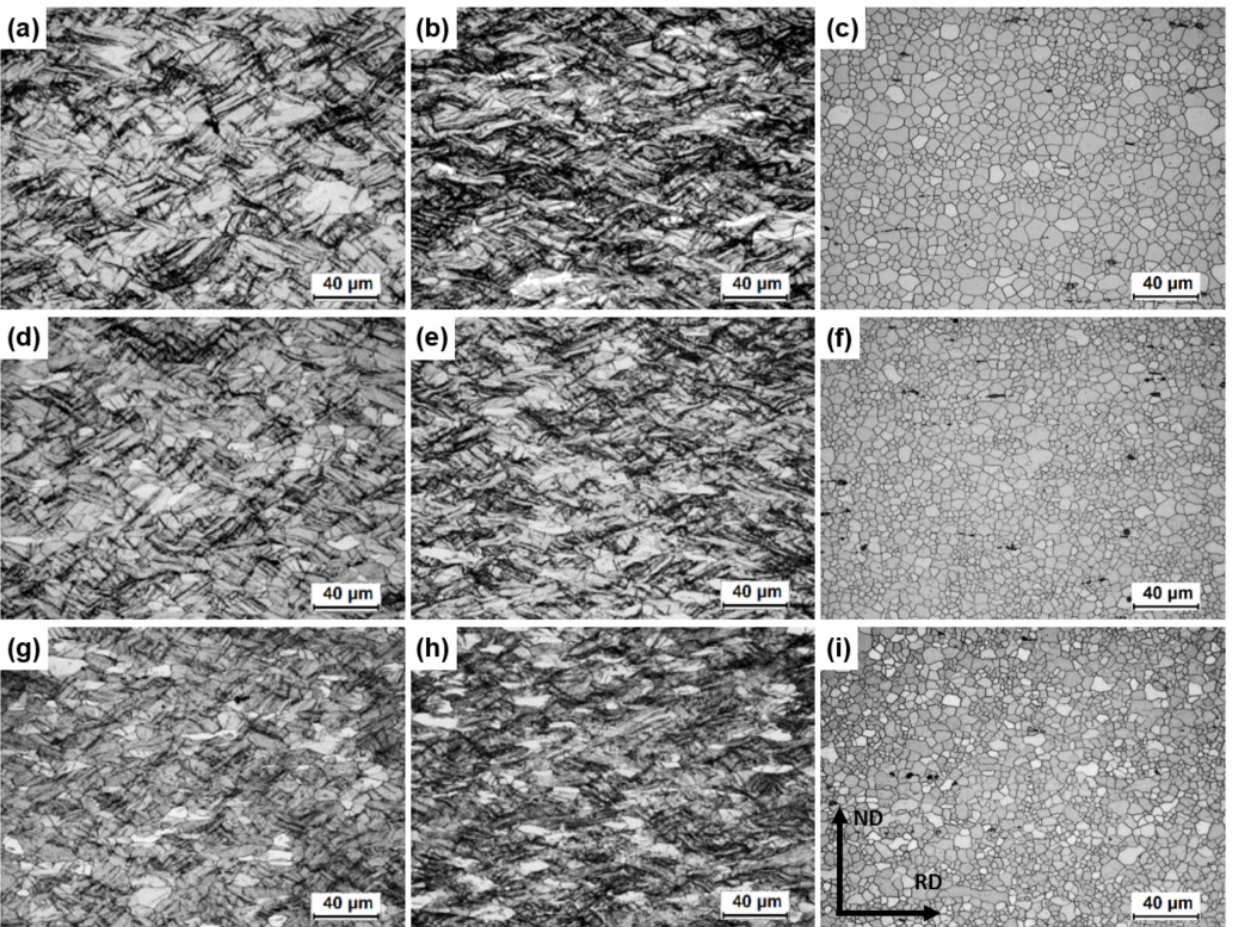
Figure 1. Optical micrographs of the hot-rolled ( a , d , g ), cold-rolled ( b , e , h ), and subsequently an- nealed ( c , f , i ) sheets: ( a – c ) AZXW3100, ( d – f ) AZXW2100, and ( g – i ) AZXW1100.